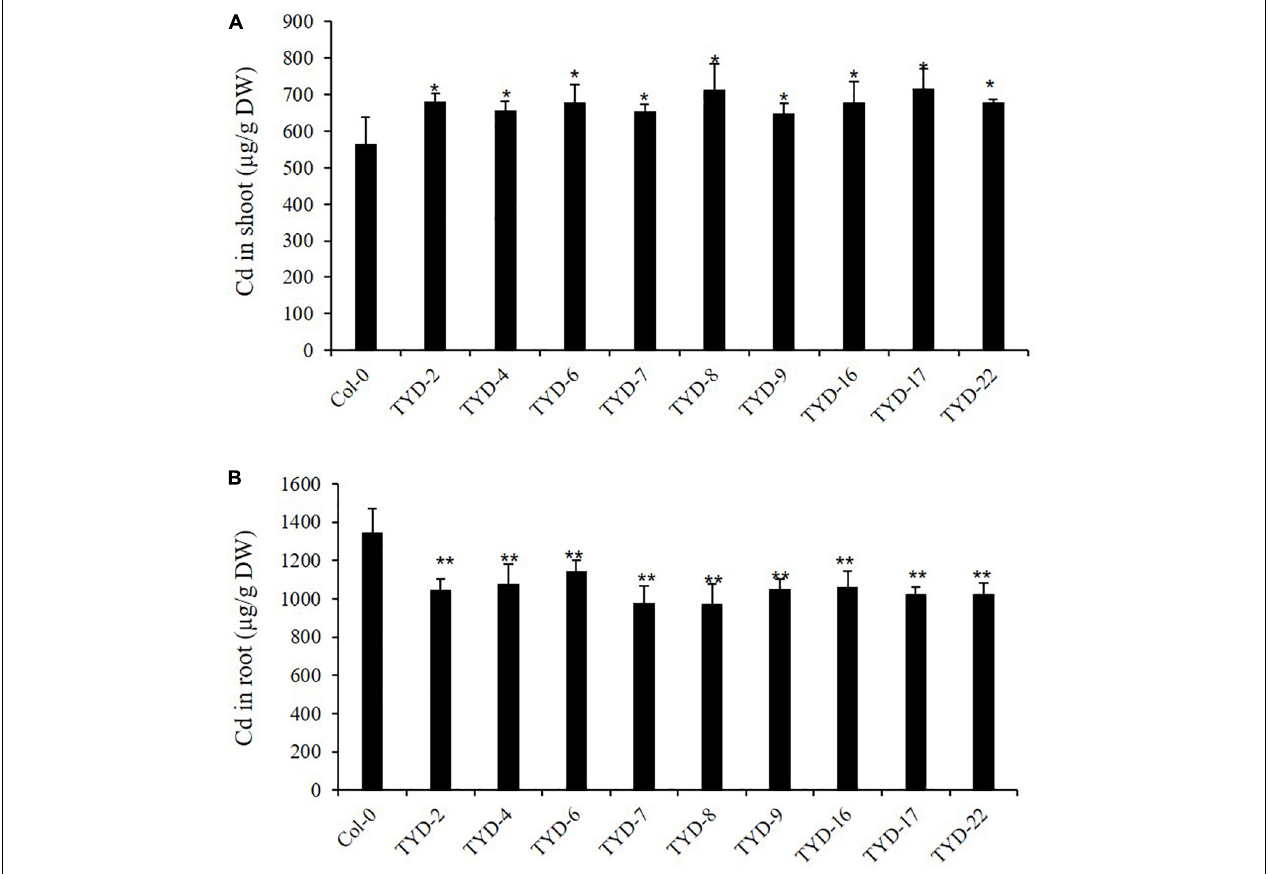
FIGURE 5 | Ectopic expression of CAL2 increased Cd allocation to shoot in Arabidopsis . Four weeks old 35S:CAL2-mRFP transgenic plants were exposed to 10 µ M Cd for 3 days. (A) Heterologous overexpression of CAL2 increased Cd concentration in Arabidopsis shoots. (B) Heterologous overexpression of CAL2 decreased Cd concentration in Arabidopsis roots. Data are mean ± standard deviations of three independent biological replicates. Significant differences from Col-0 were determined by Student’s t -test (* P < 0.05, ** P < 0.01).